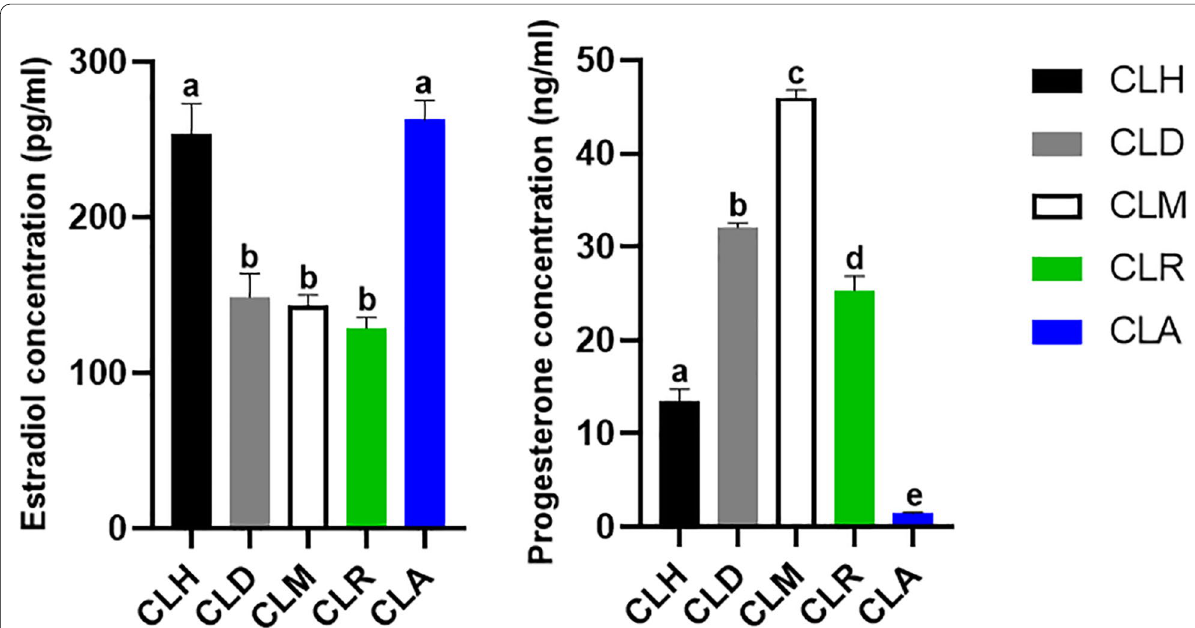
Fig. 3 The level of steroid hormones (E2 and P4) in the serum at different stages of corpus luteum in Egyptian buffaloes. Bars are presented as mean SEM. a,b,c,d Statistical differences between different stages of CL: hemorrhagic (CLH), developing (CLD), mature (CLM), regressed (CLR), and ± albicans (CLA)